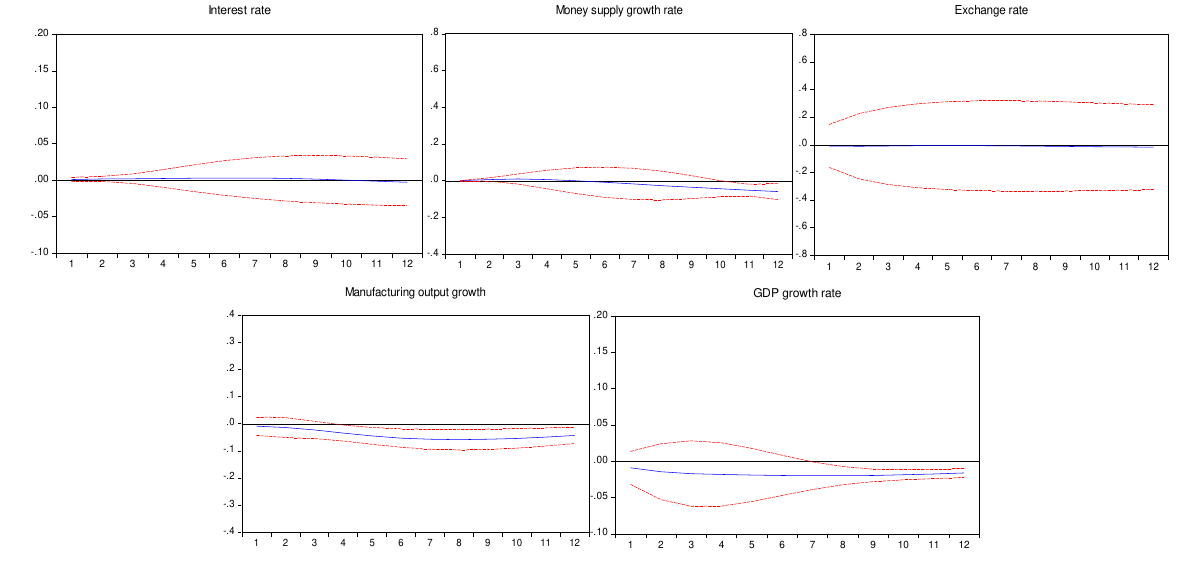
Figure 5: Responses of selected variables to an inflation rate shock in